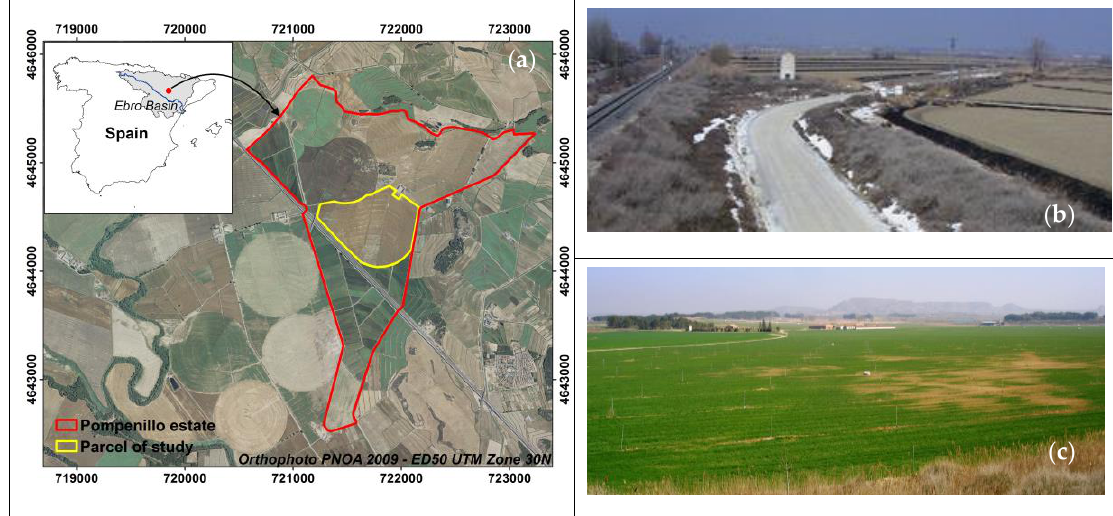
Figure 1. Location of Pompenillo estate ( a ); and examples of salinity problems: on 16 March 2005, white efflorescence in a road and its borders adjacent to just plowed irrigable plots ( b ); and, on 12 March 2009, patches with nil development of barley due to the high soil salinity levels ( c ).